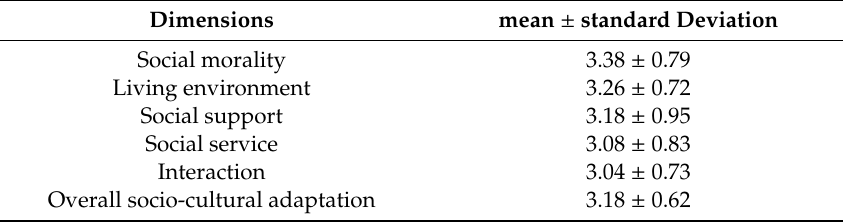
Table 2. Socio-cultural adaptation scores of the study population (data presented as mean ± standard